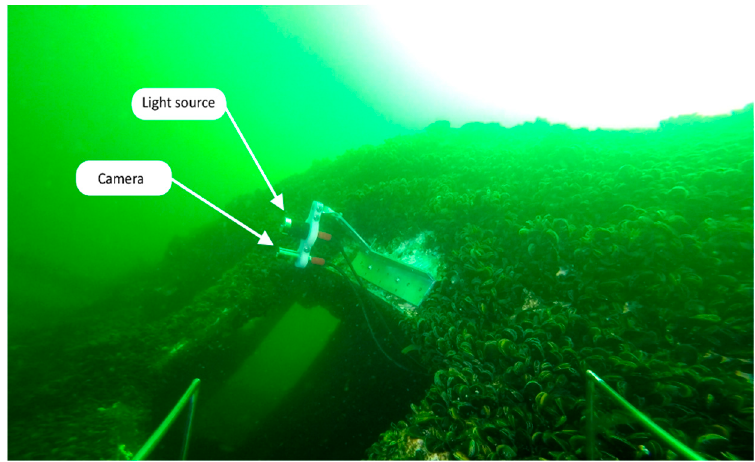
Figure 5. Setup of camera and light source on the sunken ferry.